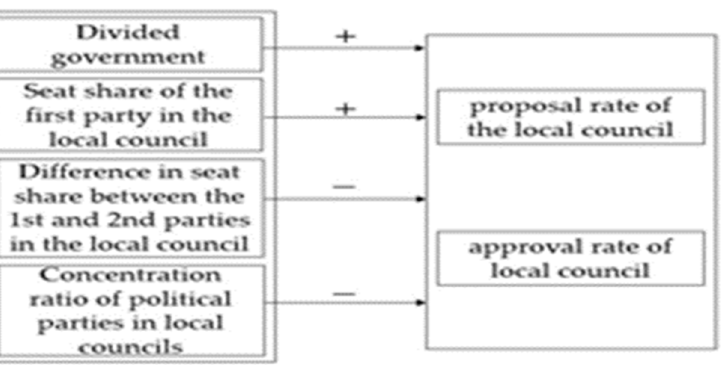
Figure 2. Analysis framework.